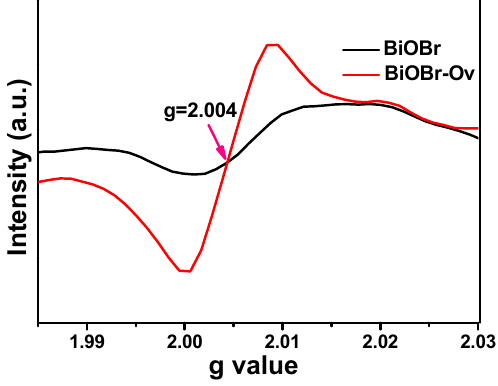
Figure 4. Electron paramagnetic resonance (EPR) spectrum of the obtained samples.